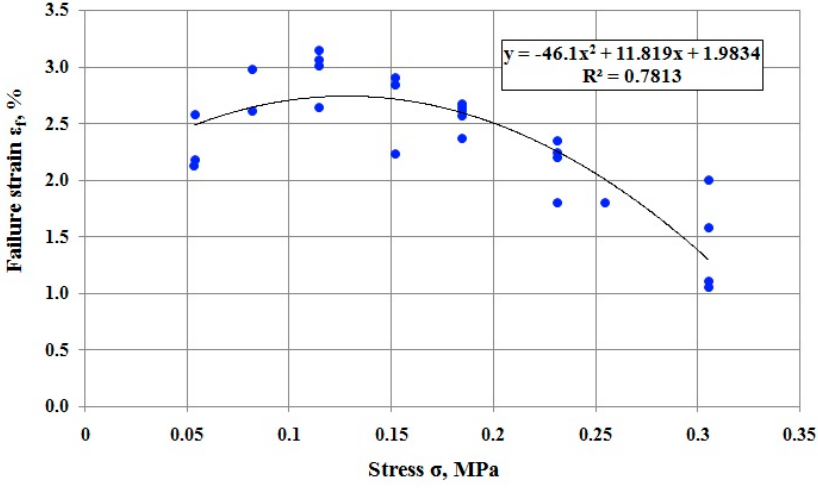
Figure 5. Dependence of failure strain for the asphalt concrete on stress.